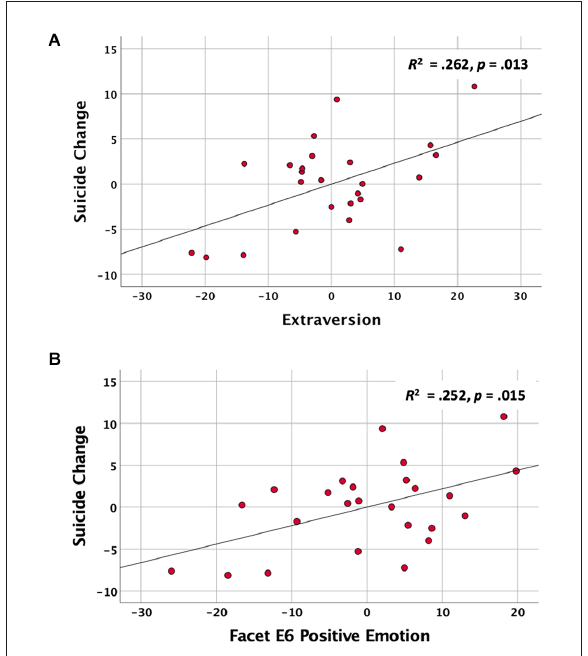
FIGURE1 The associations between extraversion traits on the NEO-PI-R and change in suicidal ideation (SUI) scores over two nights of total sleep deprivation after controlling for caffeine intake and changes in depression. (A) Partial regression plot showing the association between baseline trait extraversion (TE) and change in SUI scores during sleep deprivation. (B) Partial regression plot showing the association between the Positive Emotion facet (E6) and changes in SUI scores during sleep